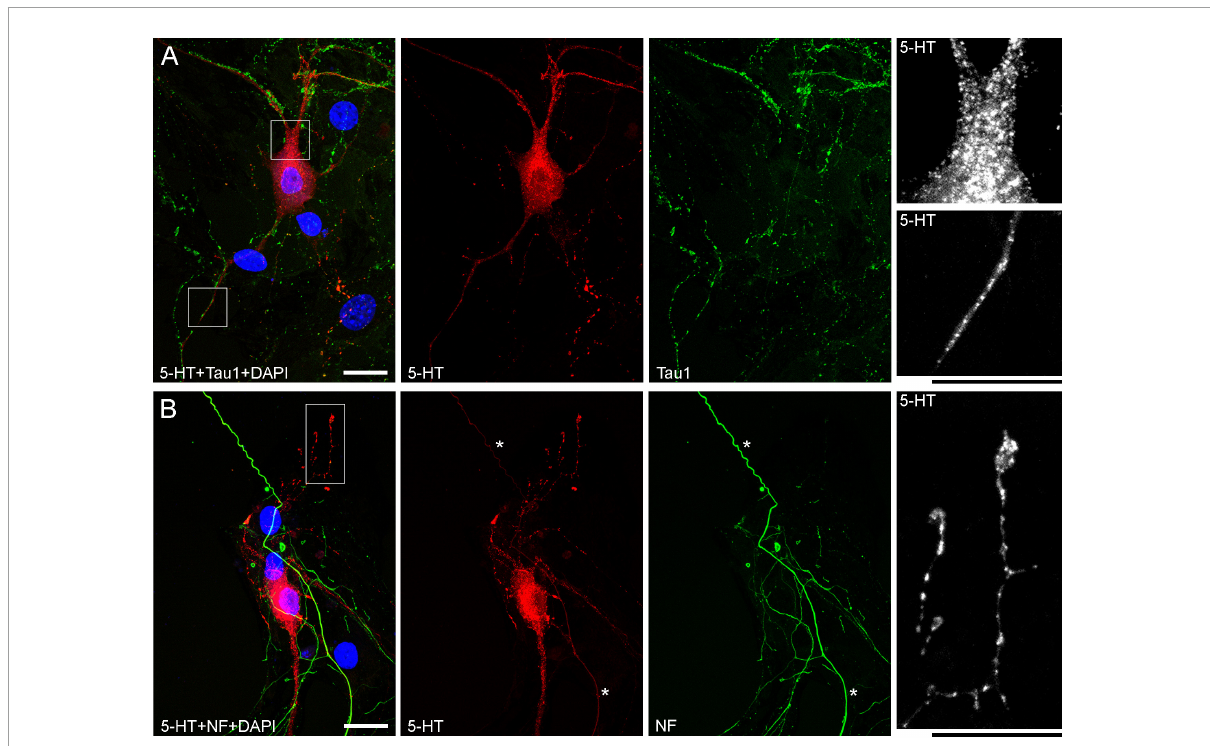
FIGURE5 Primary midbrain cultures (both monolayers at DIV 13), visualized with immunocytochemistry for 5-HT (red) and either Tau-1 or neurofilaments (green) and imaged with high-resolution confocal microscopy. (A) There is no overlap between the 5-HT and Tau-1 signals, but both serotonergic (5-HT + /Tau-1–) and non-serotonergic (5-HT–/Tau-1 +) axons have segments with alternating signal intensities. It suggests that in serotonergic axons this property cannot be explained solely by 5-HT accumulation. In serotonergic neurons, the 5-HT signal tends to accumulate in puncta, but segments with no puncta are still detectable in neurites with a constant caliber (insets, with the corresponding regions marked with the rectangles in the merged image). (B) Generally, there is no overlap between the 5-HT and neurofilament signals (NF), but some strongly NF-positive and weakly 5-HT-positive axons with continuous 5-HT-immunoreactivity are present (asterisks). In some serotonergic axons with growth cones, gradually narrowing axon segments are clearly visible (inset, with the corresponding region marked with the rectangle in the merged image). Scale bars = 20 µ